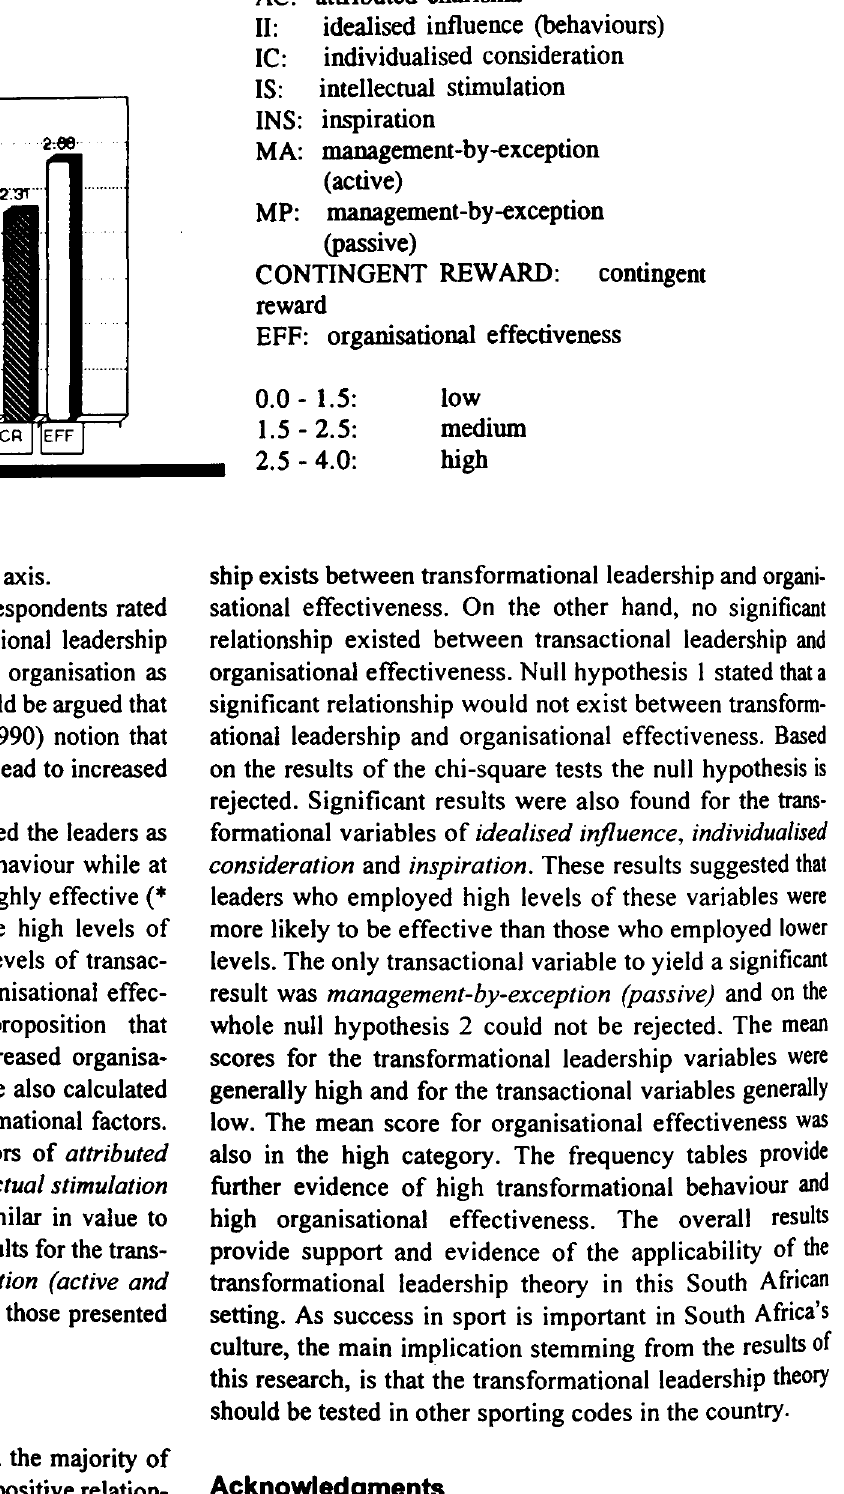
Transactional factors (•/o)